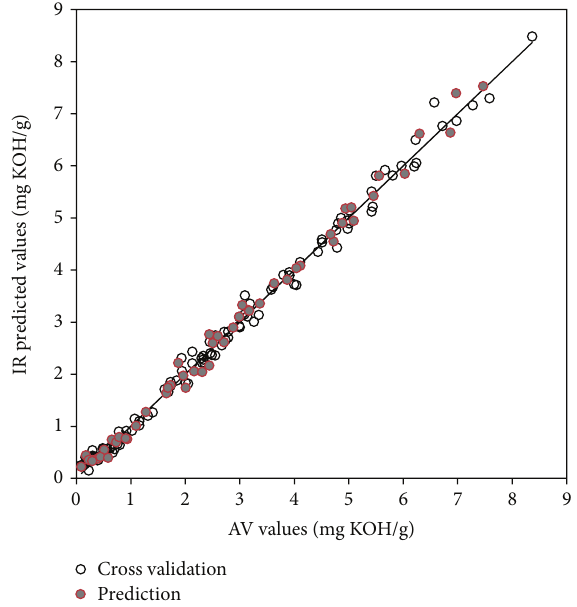
Figure 3: Relationship between actual and IR-predicted AV